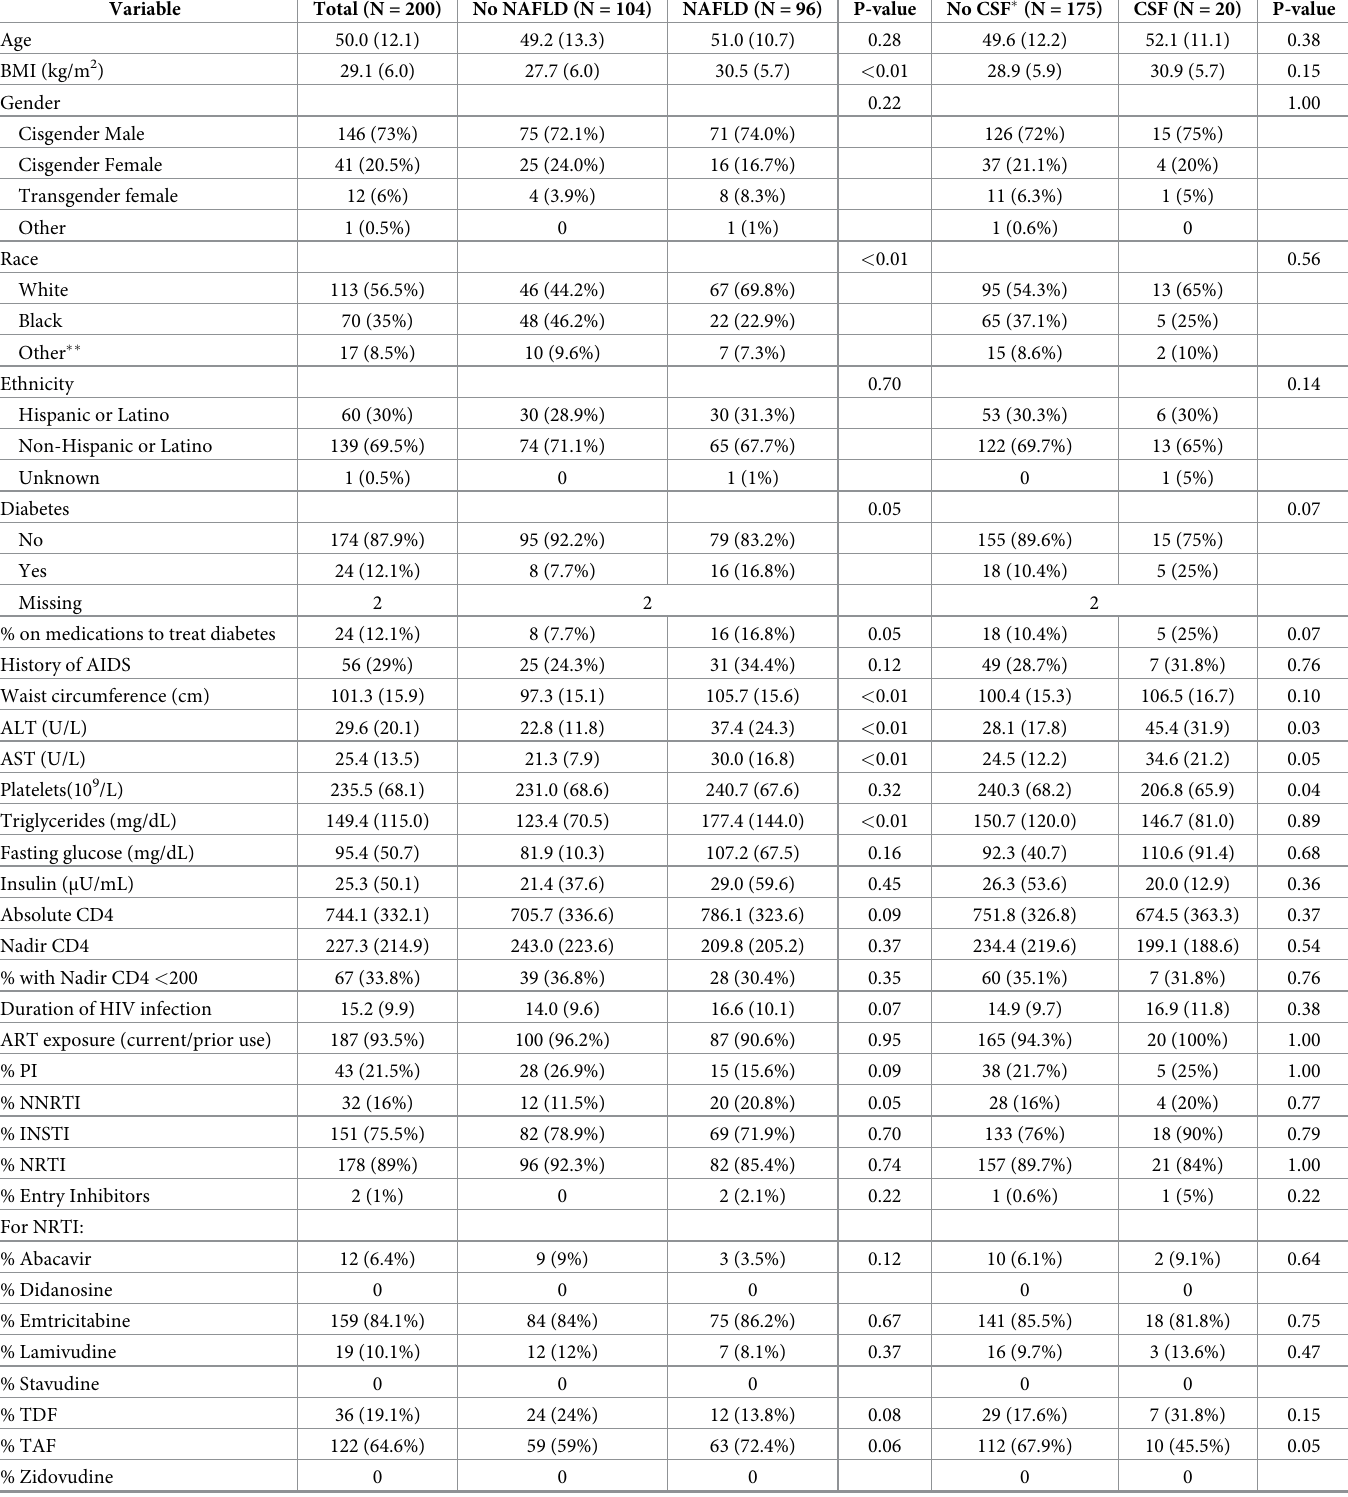
Table 1. Characteristics of persons with